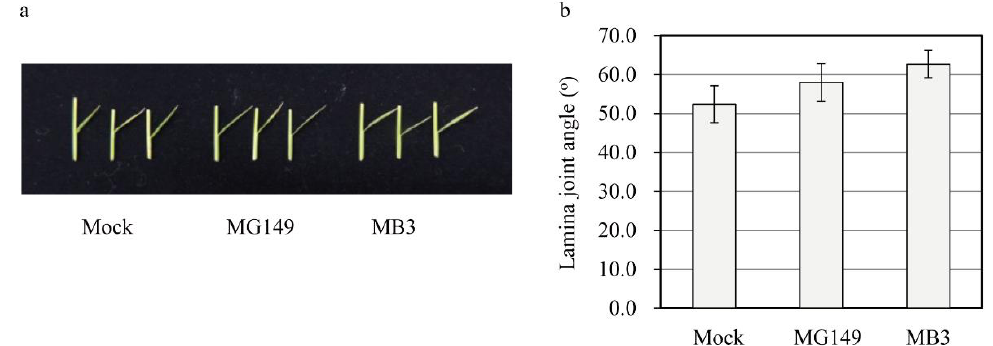
Figure 5. Measuring the lamina joint angle in response to MG149 and MB3. ( a ) Photograph of the lamina joint angle. ( b ) Bending angle of lamina joint. Seven-day-old rice seedlings grown in soil were dissected at the second leaf lamina joint and floated on mock solution containing either MG149 or MB3 for 3 days in the dark. The mock contained 0.1% ethanol.